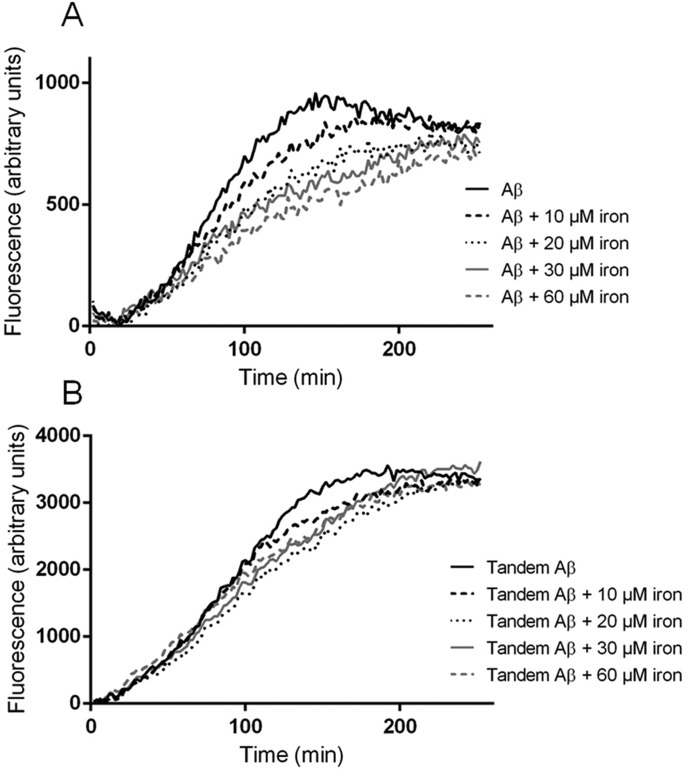
Amyloid generation by monomeric and tandem Aβ is modulated differently by iron. (A) In the absence of iron, partially purified recombinant Aβ42 generated a ThT fluorescence signal similar to that of synthetic Aβ42. Increasing concentrations of iron chloride produced a characteristic delay in the ThT signal. (B) The signal generated by the tandem Aβ42 bacterial extract throughout aggregation was not retarded by equivalent concentrations of iron chloride. Values plotted are the mean of three technical replicates. The experiment was performed three times.